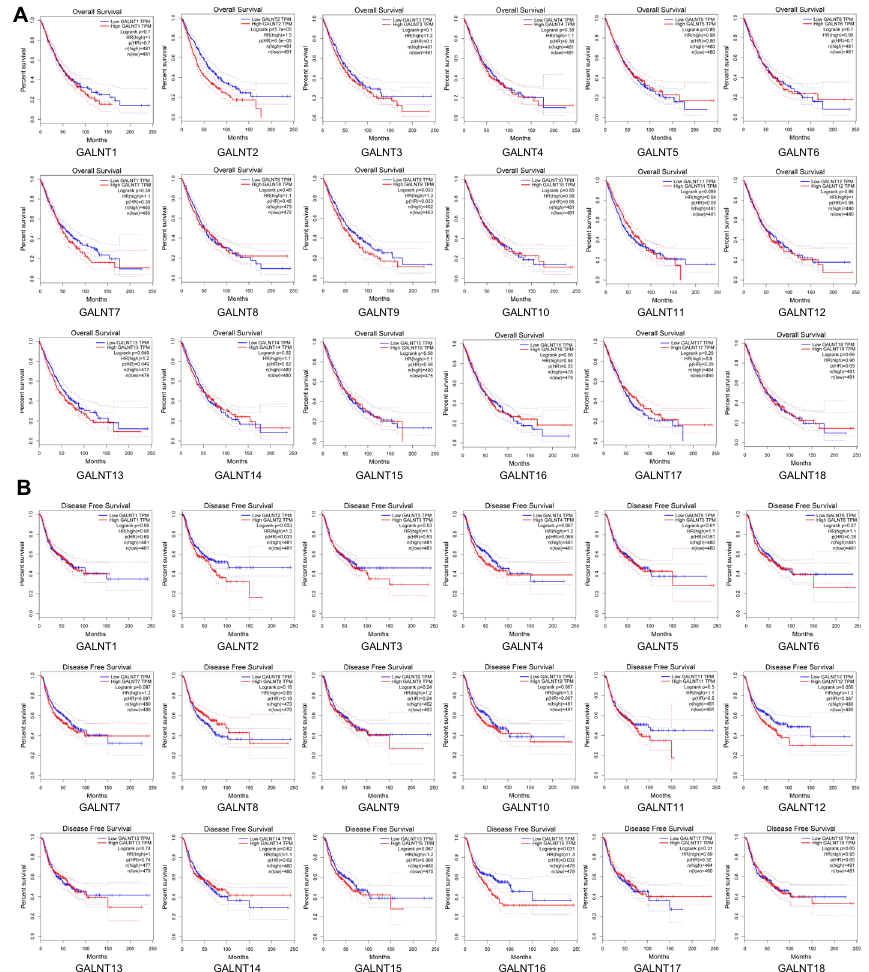
Fig. 2 Prognostic values of the GALNT family members in NSCLC. A Relationship between GALNT expression and overall survival. B Relationship between GALNT expression and disease free survival. Data for GALNT19 and GALNT20 were not